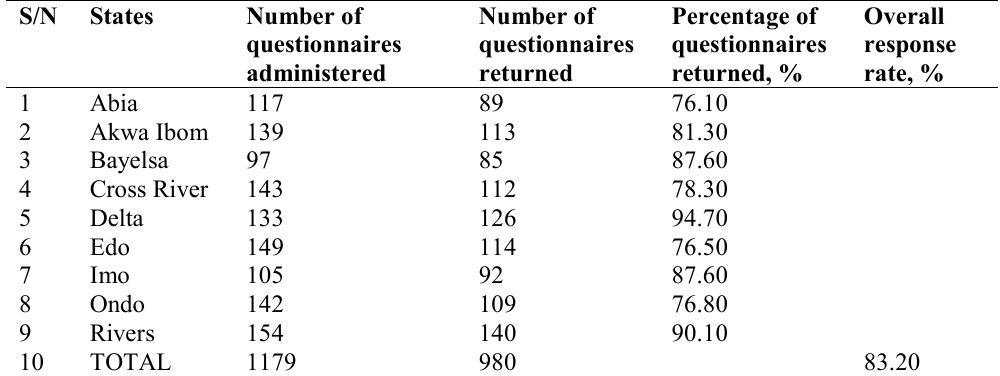
Table 2. Questionnaire Distribution and Response Rate ( Otali et al. , 2019) (developed by the